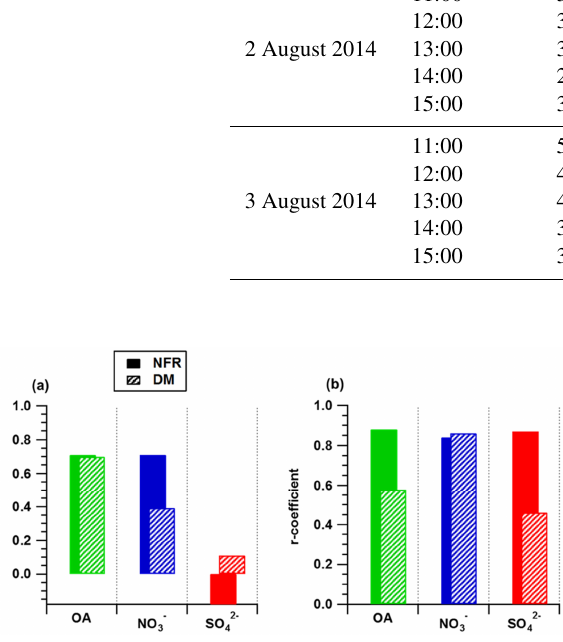
Figure 15. Correlation coefficients of scatterplots of β ext against individual aerosol species for NFR and DM during (a) non-cyclone and (b) cyclone